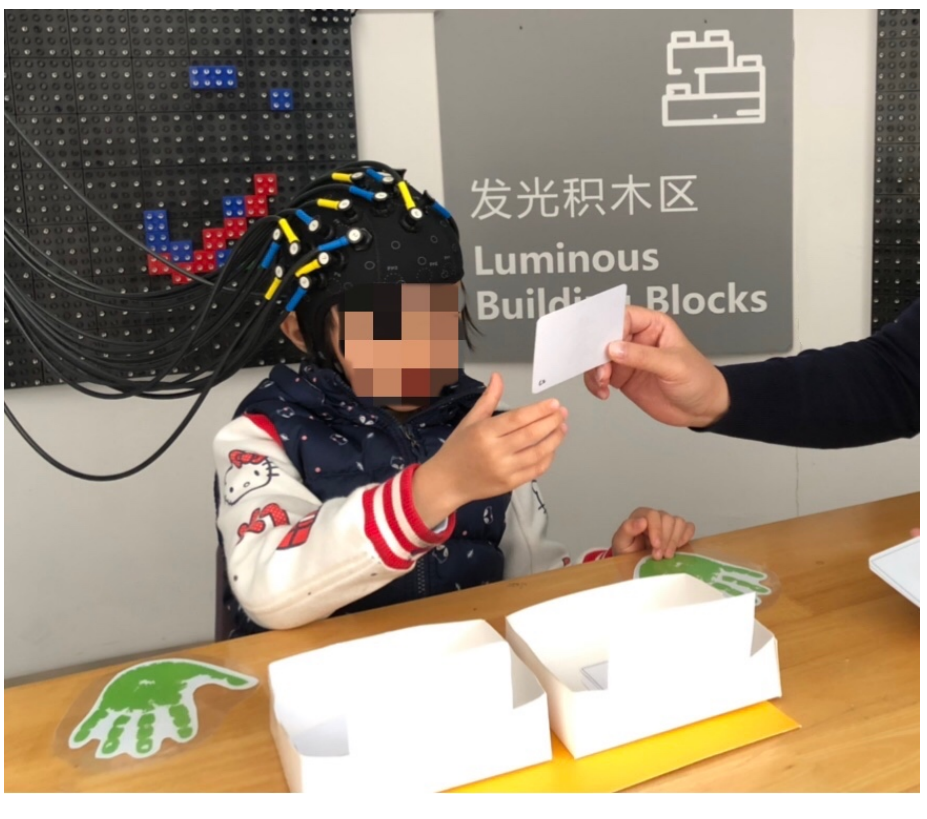
Figure 1. The Dimensional Change Card Sort (DCCS) tasks.